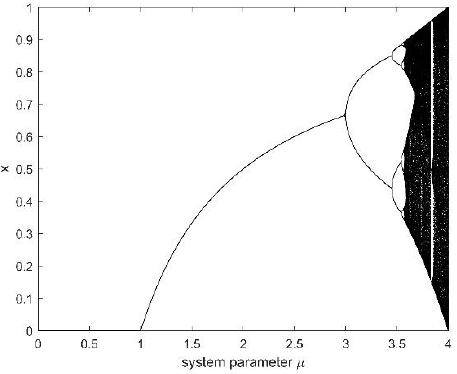
Figure 1. Bifurcation diagram.